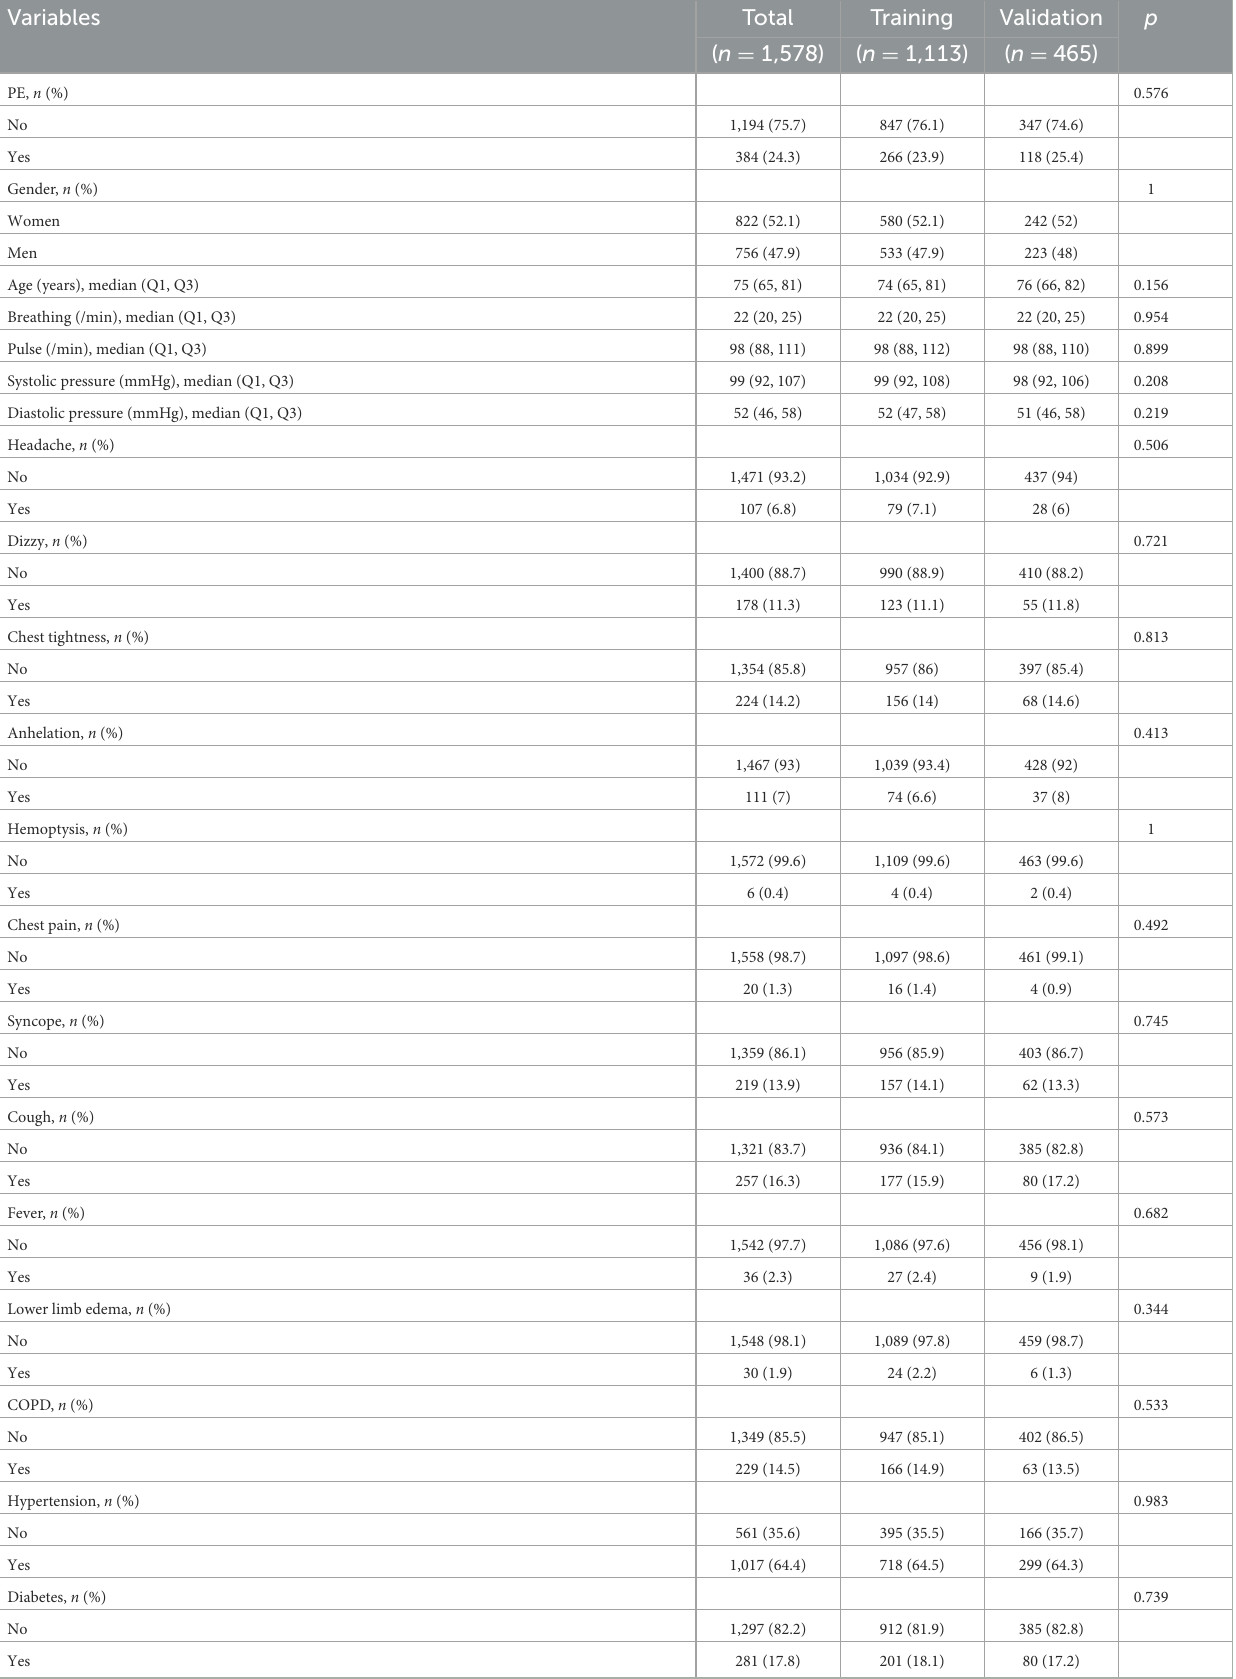
TABLE 2 The baseline characteristics of the enrolled patients in the training and validation cohorts. Variables Total Training